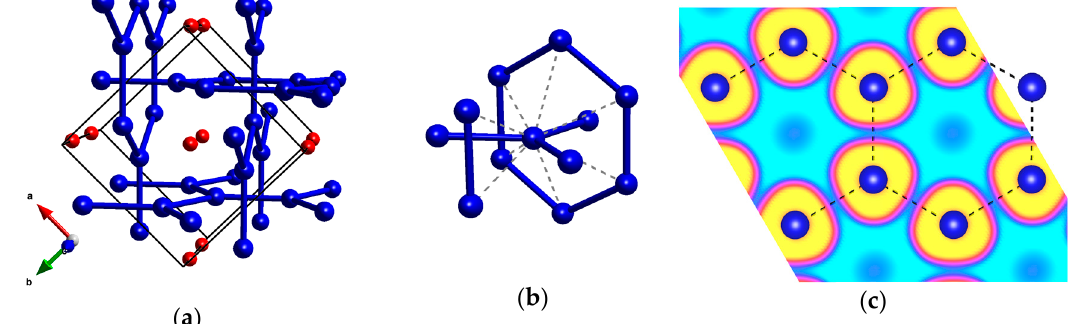
Figure 4. ( a ) the I4/mcm structure of Kr 2 F; ( b ) the coordination environment of Kr with secondary Kr–Kr contacts marked with dashed lines; ( c ) ELF function for Kr 2 F at 150 GPa. Yellow color depicts ELF values above 0.9, cyan—below 0.1, while magenta corresponds to values of 0.4. Shortest Kr–Kr contacts are marked with dashed lines.